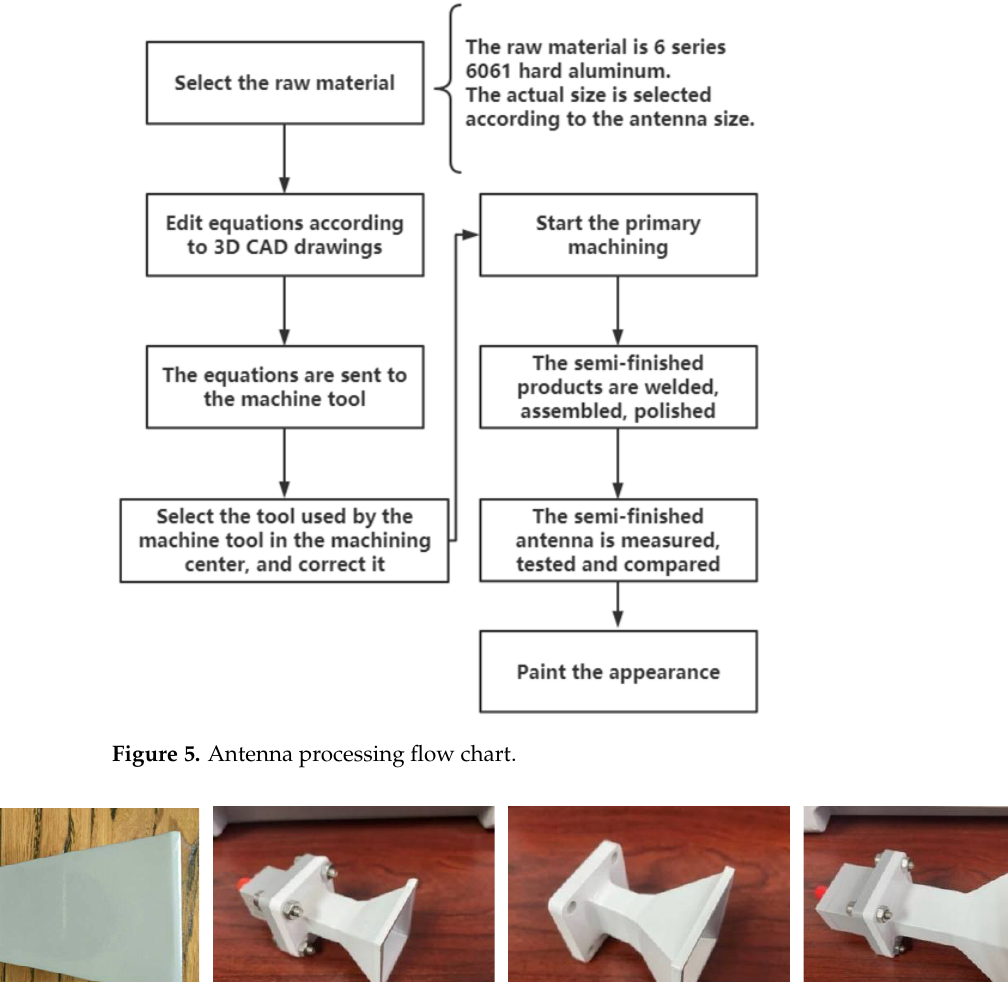
Figure 7. Block diagram of multiband full-power microwave temperature radiometer.